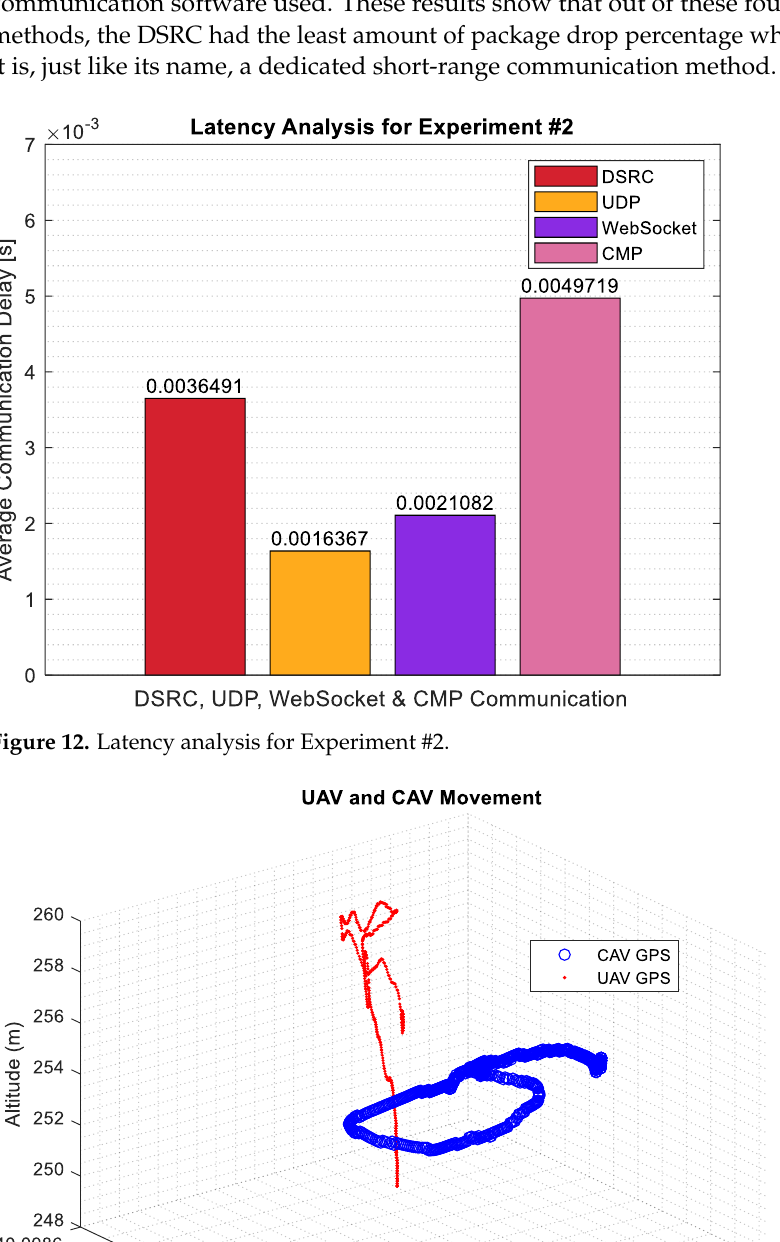
Figure 13. CAV GPS and UAV GPS locations for Experiment #2.